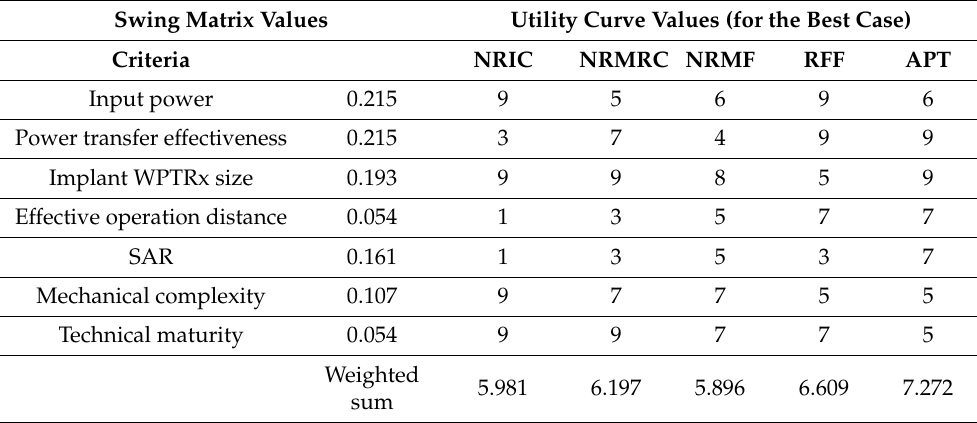
Table 2. Summary of results of the trade-off analysis. Weights are normalized with respect to the total weight sum of the swing matrix values (weight sum =